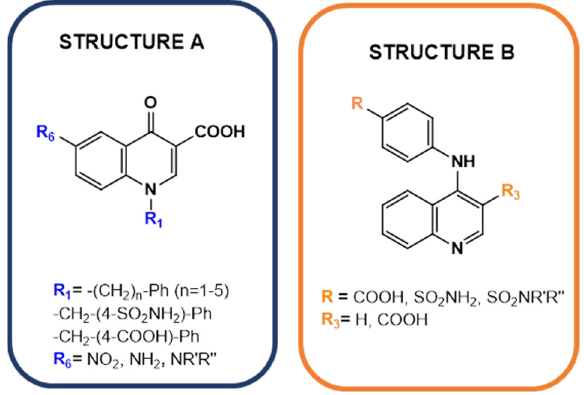
Figure 2. New Panx-1 blockers with quinoline scaffold.